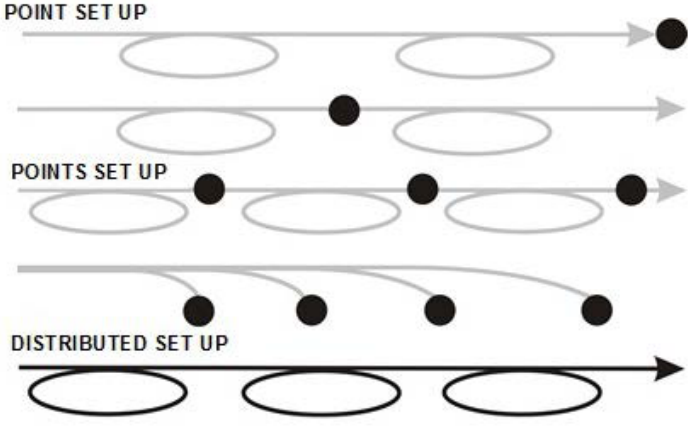
Figure 4. Basic scheme of FOS—Black points refer the sensing point (play) [70]. Reproduced from [47] with the permission of the CTU editors.